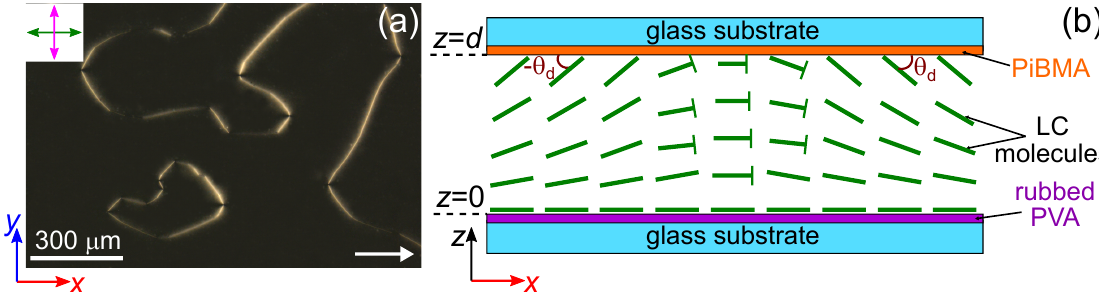
Figure 2. POM photo of LN-396 nematic layer with PiBMA film on the top substrate ( z = d ) and rubbed PVA film on the bottom one ( z = 0) ( a ); The scheme of LC orientation in domains with tilt angle of director + θ d and − θ d on the PiBMA film ( b ). The LC layer thickness is d = 21 µ m. Hereinafter, the polarizer and analyzer directions are indicated by the magenta and green double arrows, respectively. The single arrow is the rubbing direction of PVA